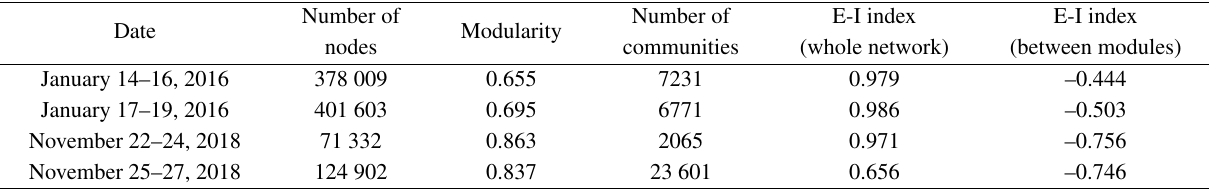
Table 3 Modularity, betweenness centrality, and E-I index of the whole networks and the subnetworks in 2016 and